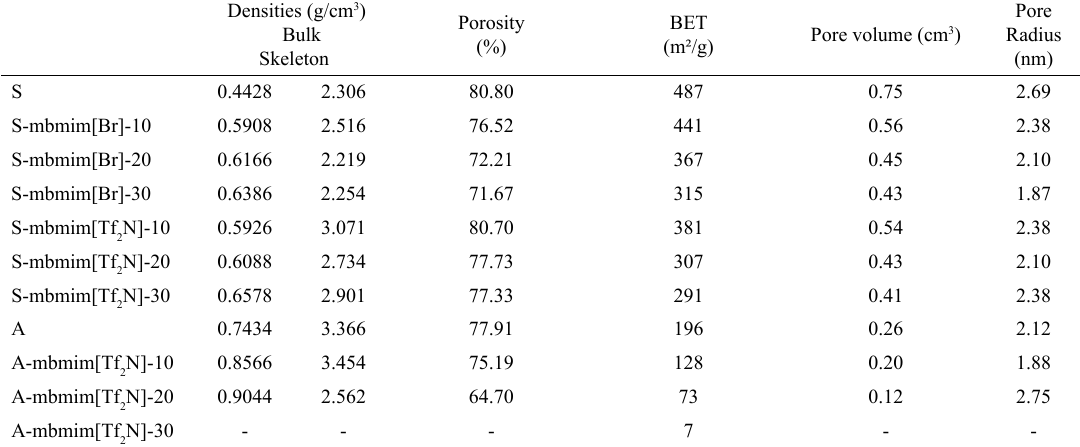
Table 2. Density and pore characteristics of all samples (S and A with and without IL